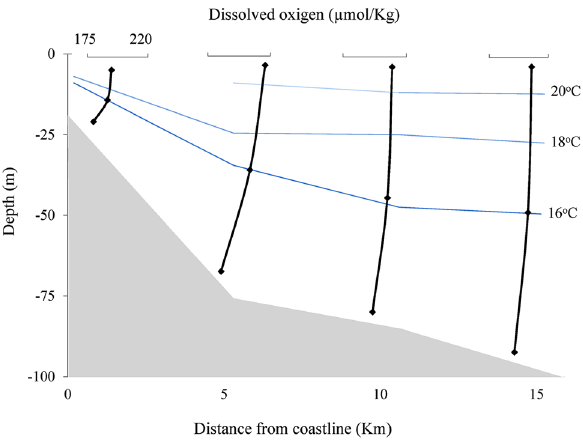
Figure 4. Dissolved oxygen in the longitudinal samples from the surface, middle, and bottom of the water